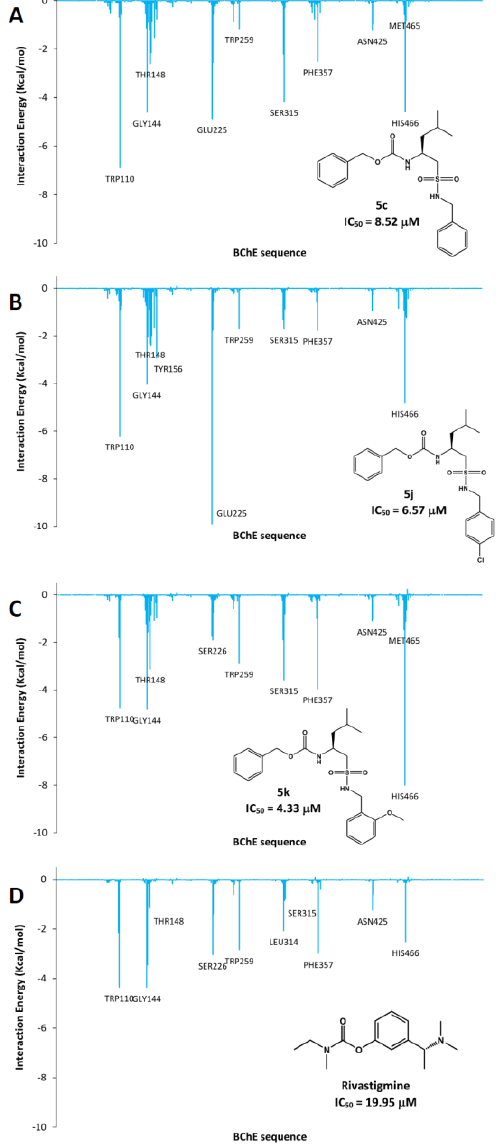
Figure 3. Histogram of interaction energies partitioned with respect to BChE amino acid sequence when complexed with compounds 5c ( A ), 5j ( B ), 5k ( C ), and RIV ( D ). The X-axis denotes the residue number of BChE, and the Y-axis denotes the interaction energy between the compound and a specific residue. Negative and positive values are favorable or unfavorable for binding, respectively.